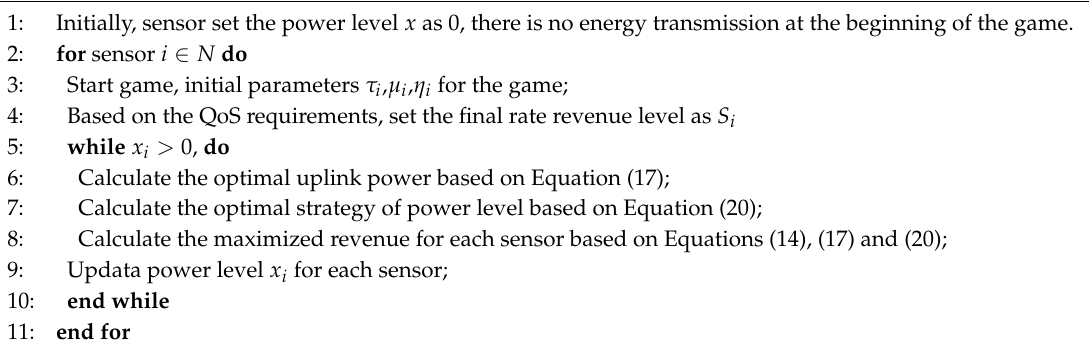
Algorithm 1. The strategy for each sensor to determine the optimal uplink transmit